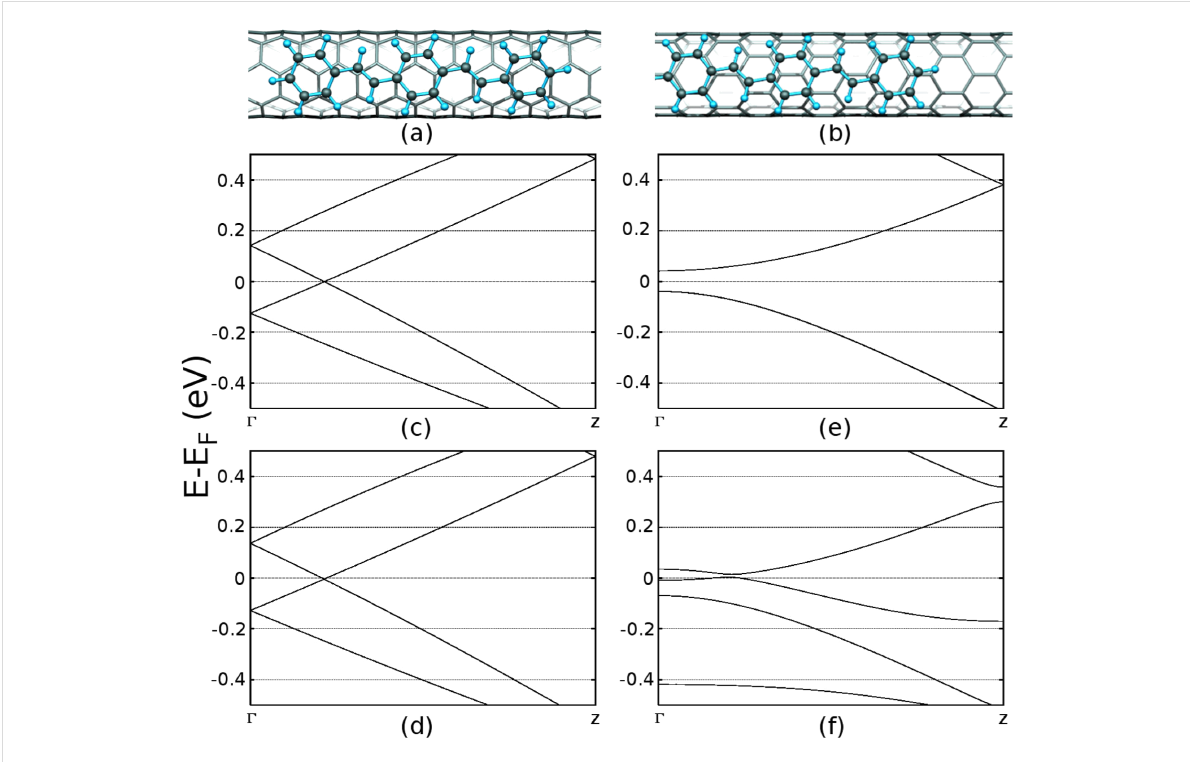
Figure 2: DFT calculations of triphenyl PPV-nanotube interaction. (a) metallic (4,4) nanotube, (b) semiconducting (7,0) nanotube. (c–f) show band structures in eV for (c,e) the isolated (4,4) and (7,0) nanotube sections, and (d,f) in conjunction with the PPV section. Fermi levels are aligned at zero.